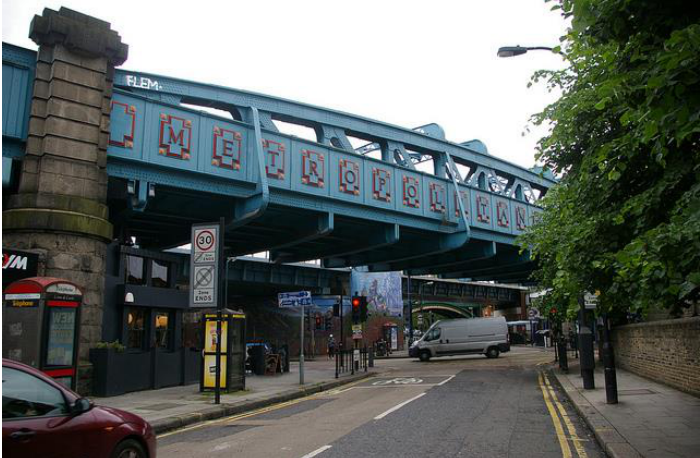
Figure 6. Kilburn High Road railway bridge. Source: Flickr, The Creative